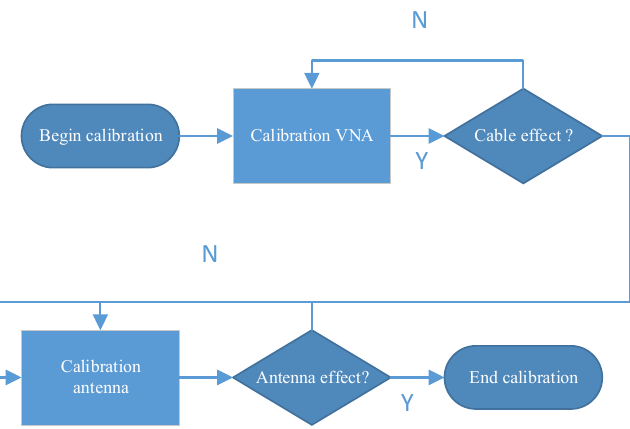
Figure 5. Radar calibration procedure using a pair of